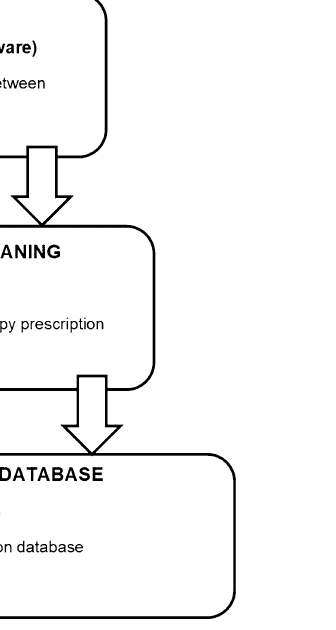
Figure 1. Schematic plan of the methodology of data